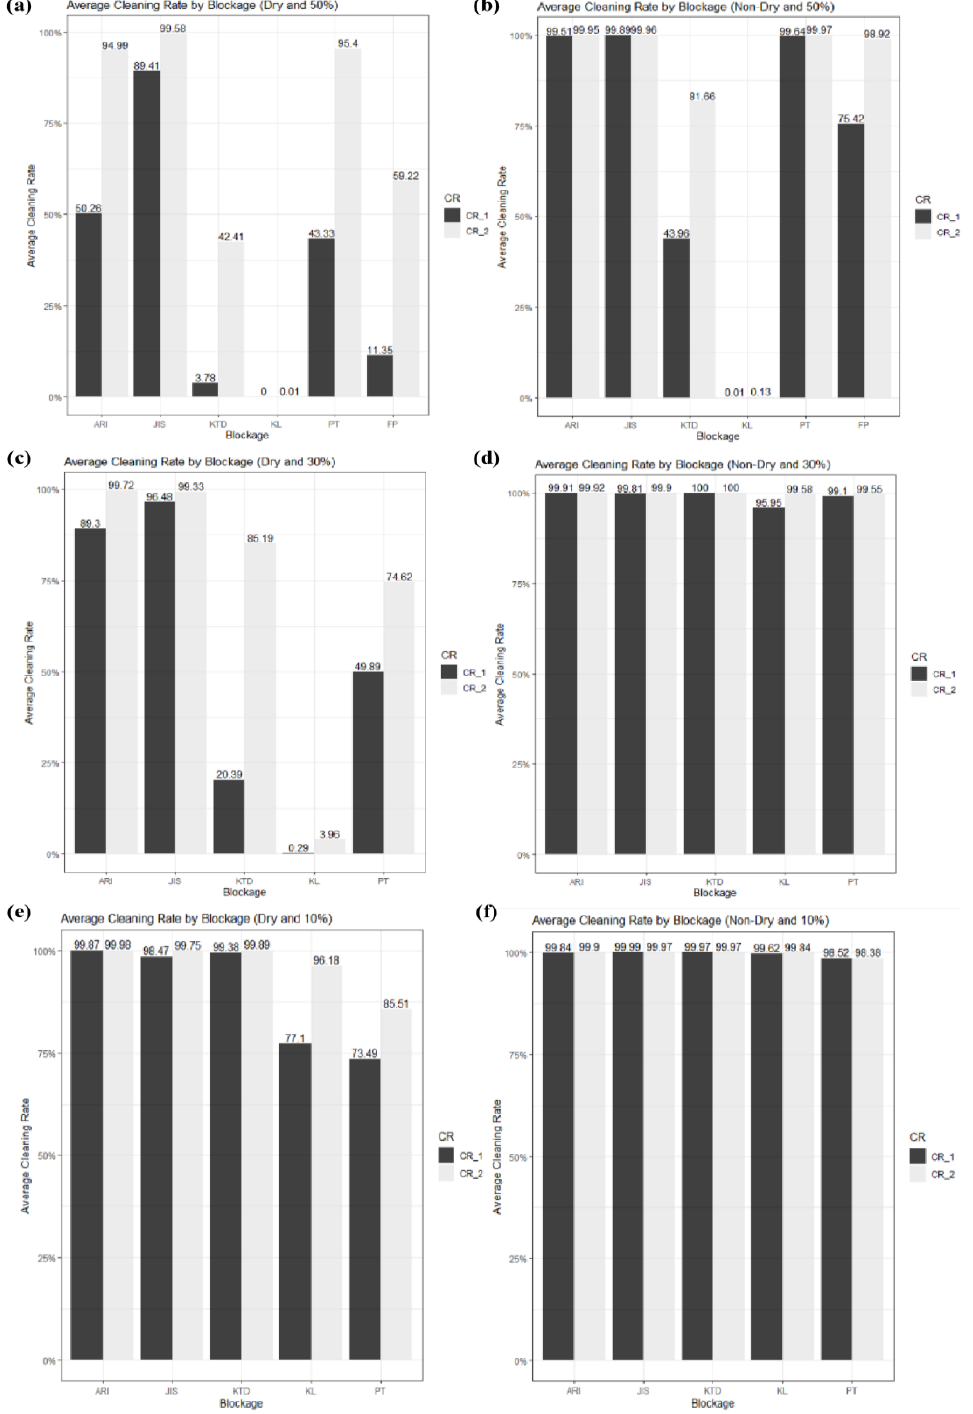
Figure 24. Difference between first and second cleaning rates. ( a ) Concentration 50%, first cleaning rate; ( b ) 50%, second cleaning rate; ( c ) 30%, first cleaning rate; ( d ) 30%, second cleaning rate; ( e ) 10%, first cleaning rate; and ( f ) 10%, second cleaning rate.